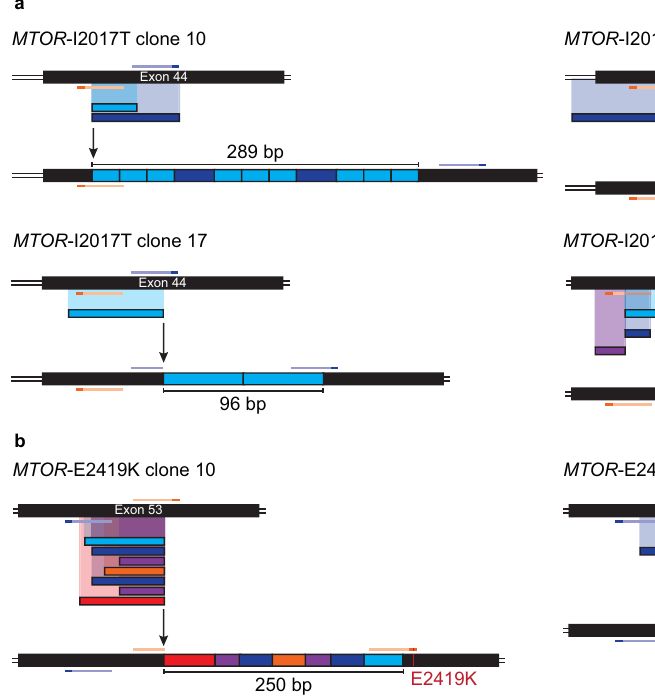
Fig. 4 | Identi fi cation and characterization of large PE3-mediated insertions in single cell-derived clones. a Schematic representation of the large insertions observed at MTOR exon 44 from single cell-derived K562 clones harboring the MTOR -I2017Thyperactivatingmutation.K562cellsstablyexpressingthemSc-TOSI reporter were transfected with PE3 vectors targeting ATP1A1 exon 4 (Q118R) and MTOR .Single cell-derived cloneswereisolated in methylcellulose-based semi-solid RPMI media supplemented with 100 µ M ouabain and genomic DNA was harvested